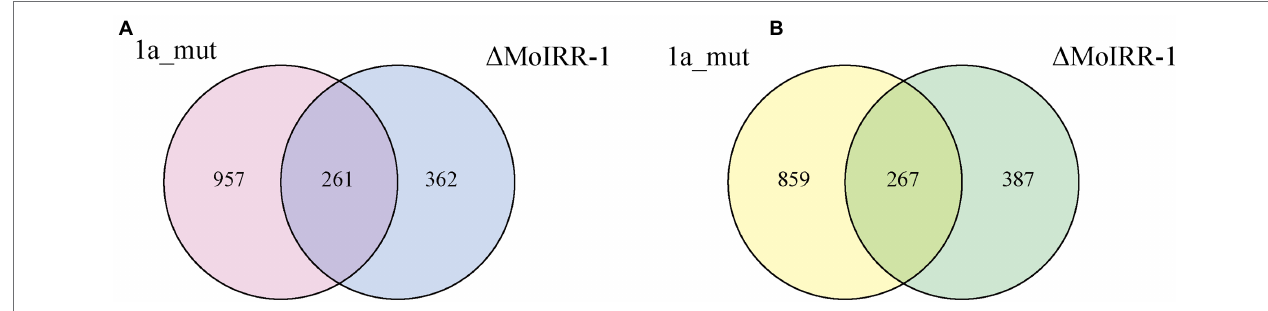
FIGURE 2 | Venn diagrams showing the number of DEGs with similar expression pattern in transcriptomic analysis of 1a_mut and Δ MoIRR-1. (A) The number of unique and shared upregulated DEGs in 1a_mut and Δ MoIRR-1 compared to H08-1a. (B) The number of unique and shared downregulated DEGs in 1a_mut and Δ MoIRR-1 compared to H08-1a.